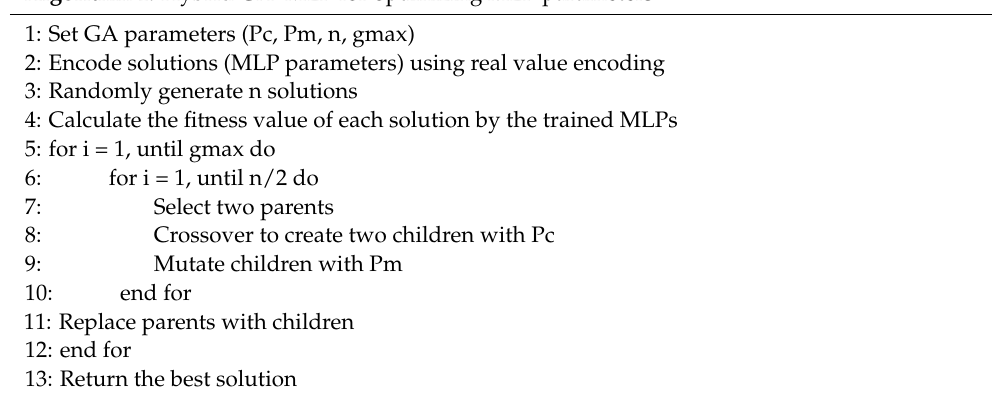
Algorithm 1. Hybrid GA–MLP for optimizing MLP